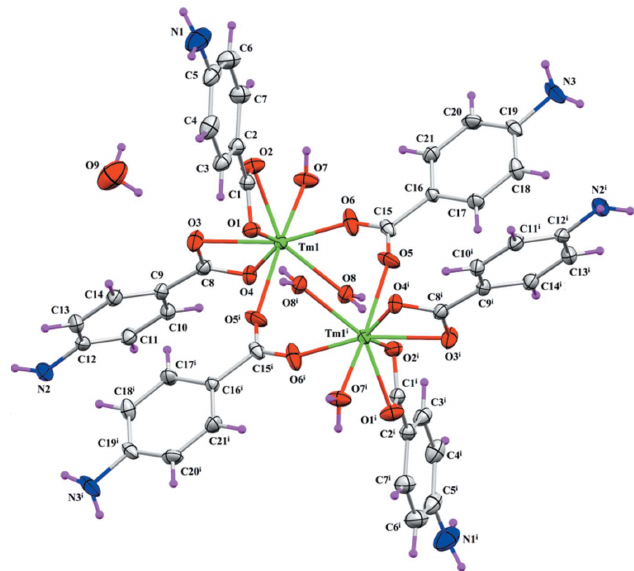
Figure 1 ORTEP view of 4ABA-Tm with ellipsoids drawn at a 30% probability level with H atoms shown as small circles of arbitrary radii.